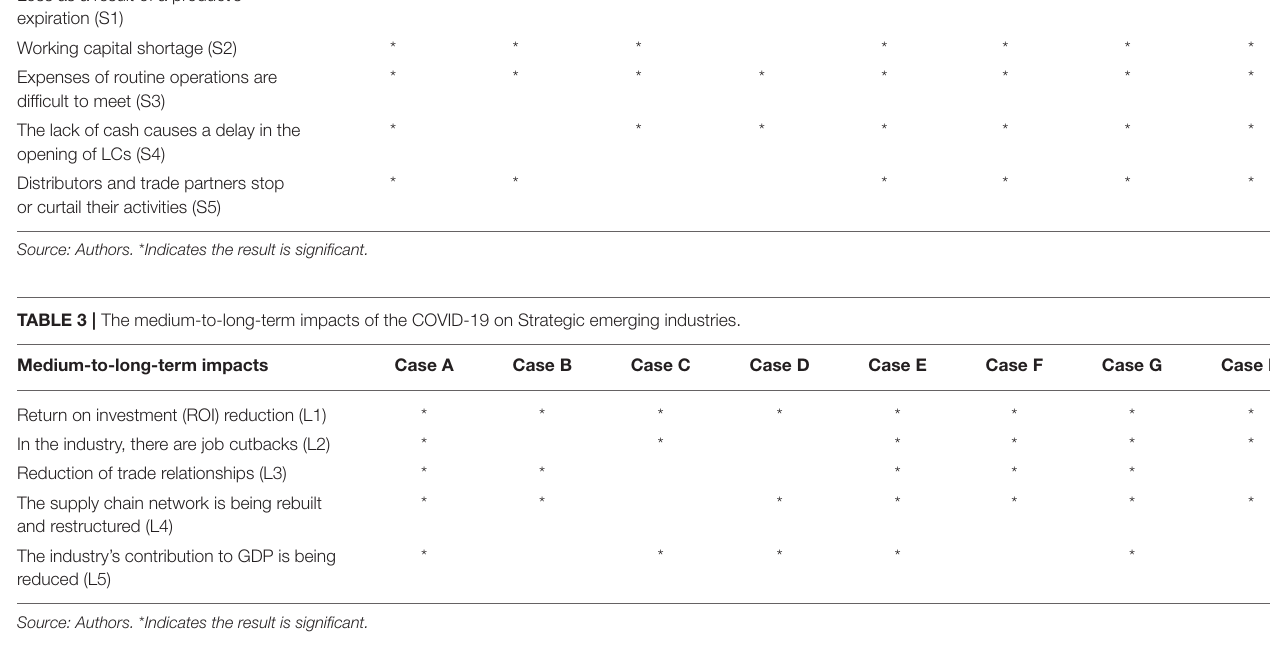
TABLE 4 | Fourier ADF unit root